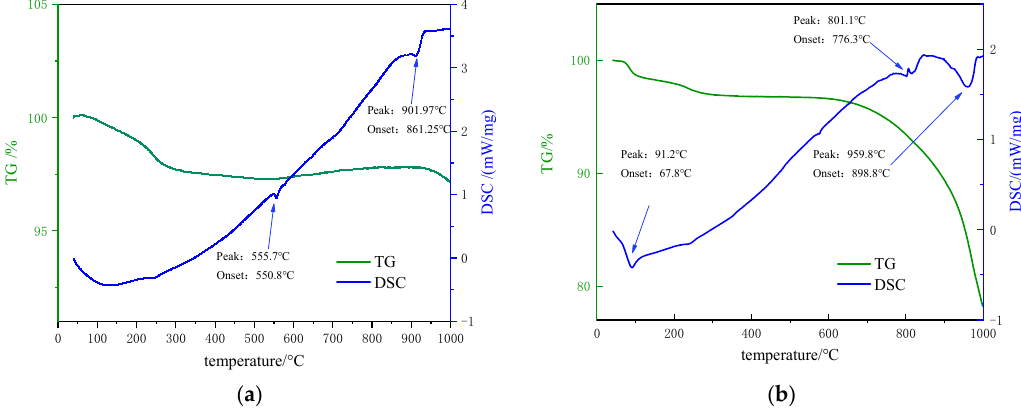
Figure 9. TG-DSC curve. ( a ) with cryolite added; ( b ) with sodium carbonate added.